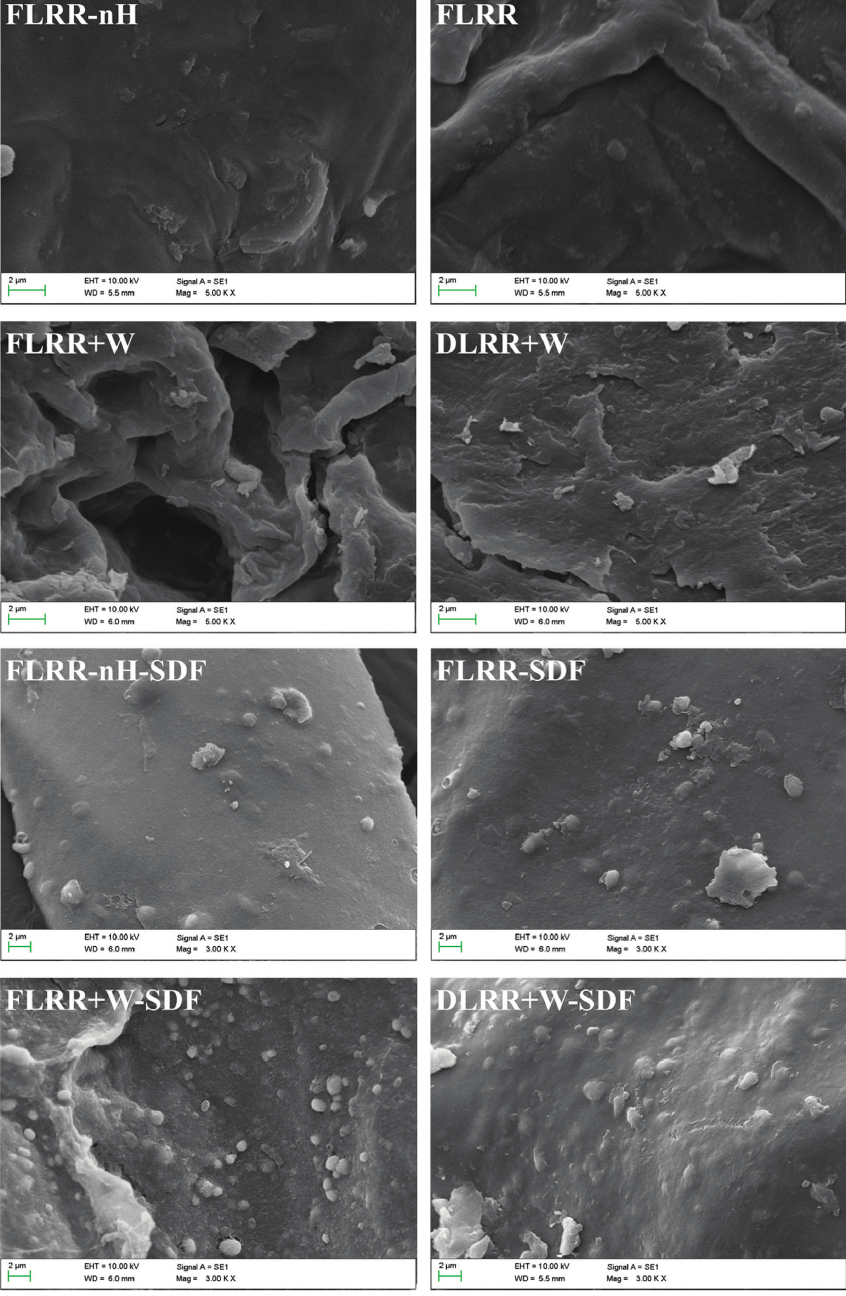
Figure 1: Scanning electron microscopy microstructure images of the LRR at 5000x magnification (FLRR-nH, FLRR, FLRR+ W , and DLRR+ W ) and SDF from LRRs at 3000x magnification (FLRR-nH-SDF, FLRR-SDF, FLRR+W-SDF, and